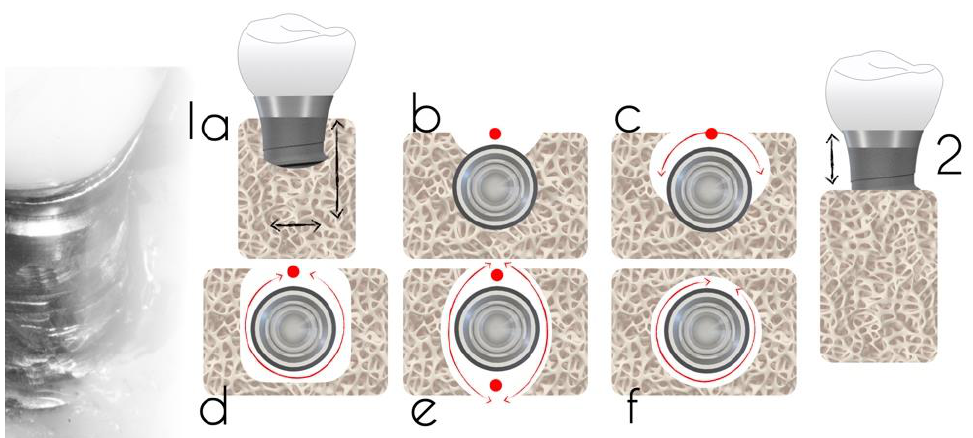
Figure 4. Defect classification according to an intra-operative assessment (adapted from Schwarz et Figure 4.